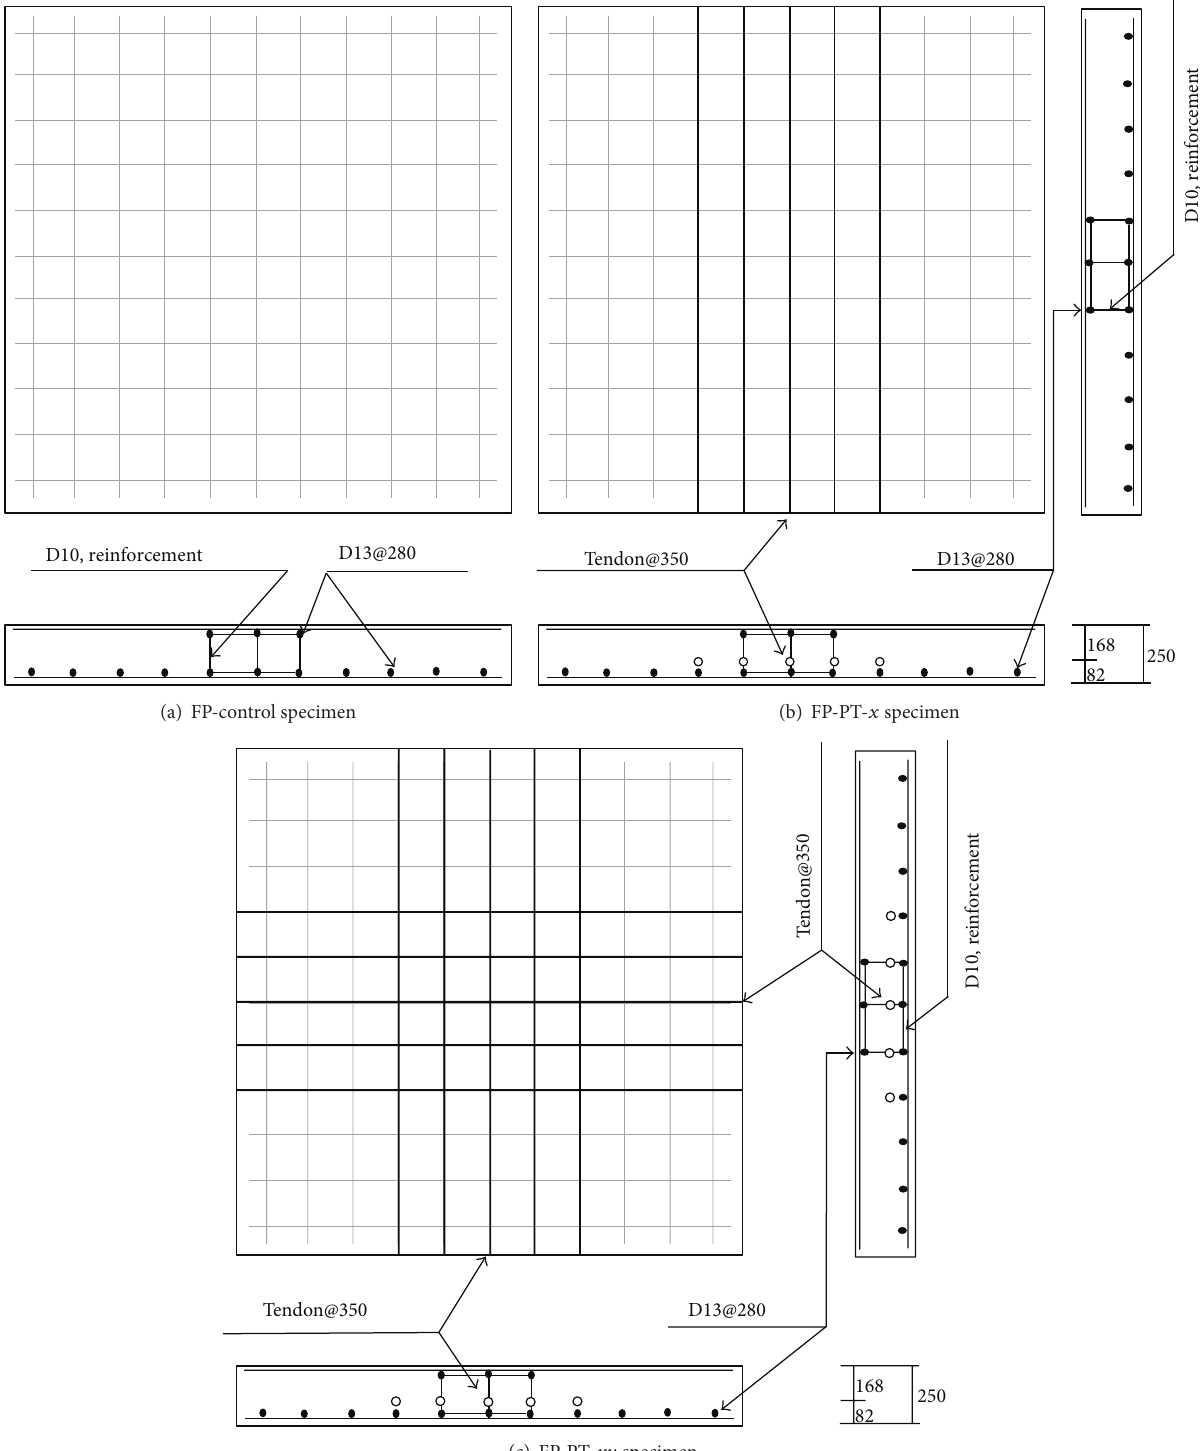
Figure 2: Details of the